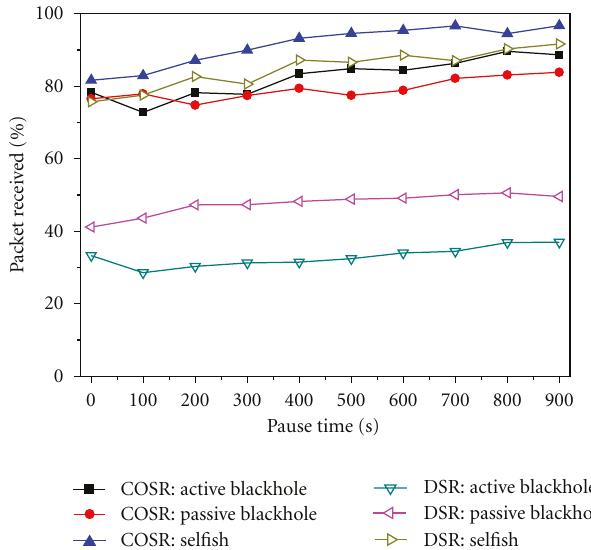
Figure 8: Throughput of COSR and DSR with various pause